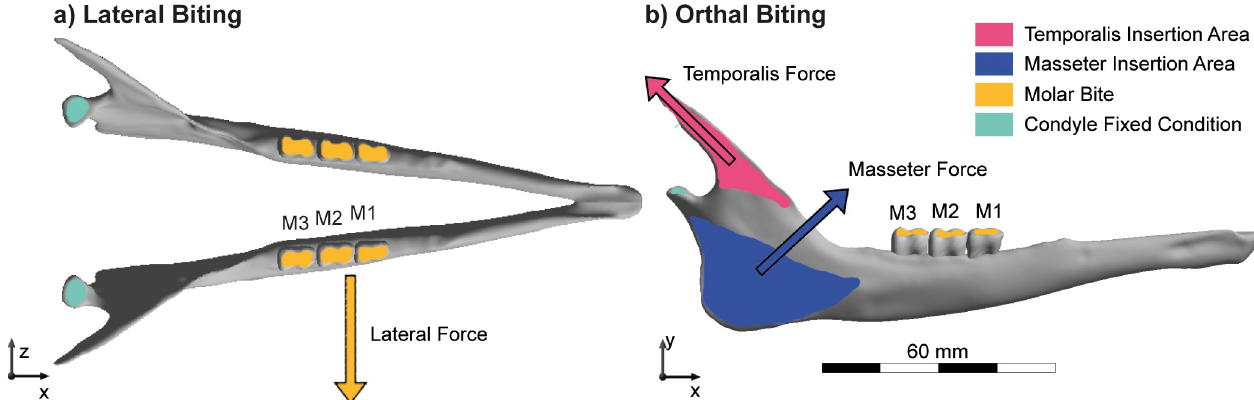
Fig 1. Free-body diagram of the biomechanical problem with boundary conditions, muscular forces, area of insertion, and bite position for each molar (M1, M2, M3) in L . walleri for a) lateral and b) orthal biting configurations.